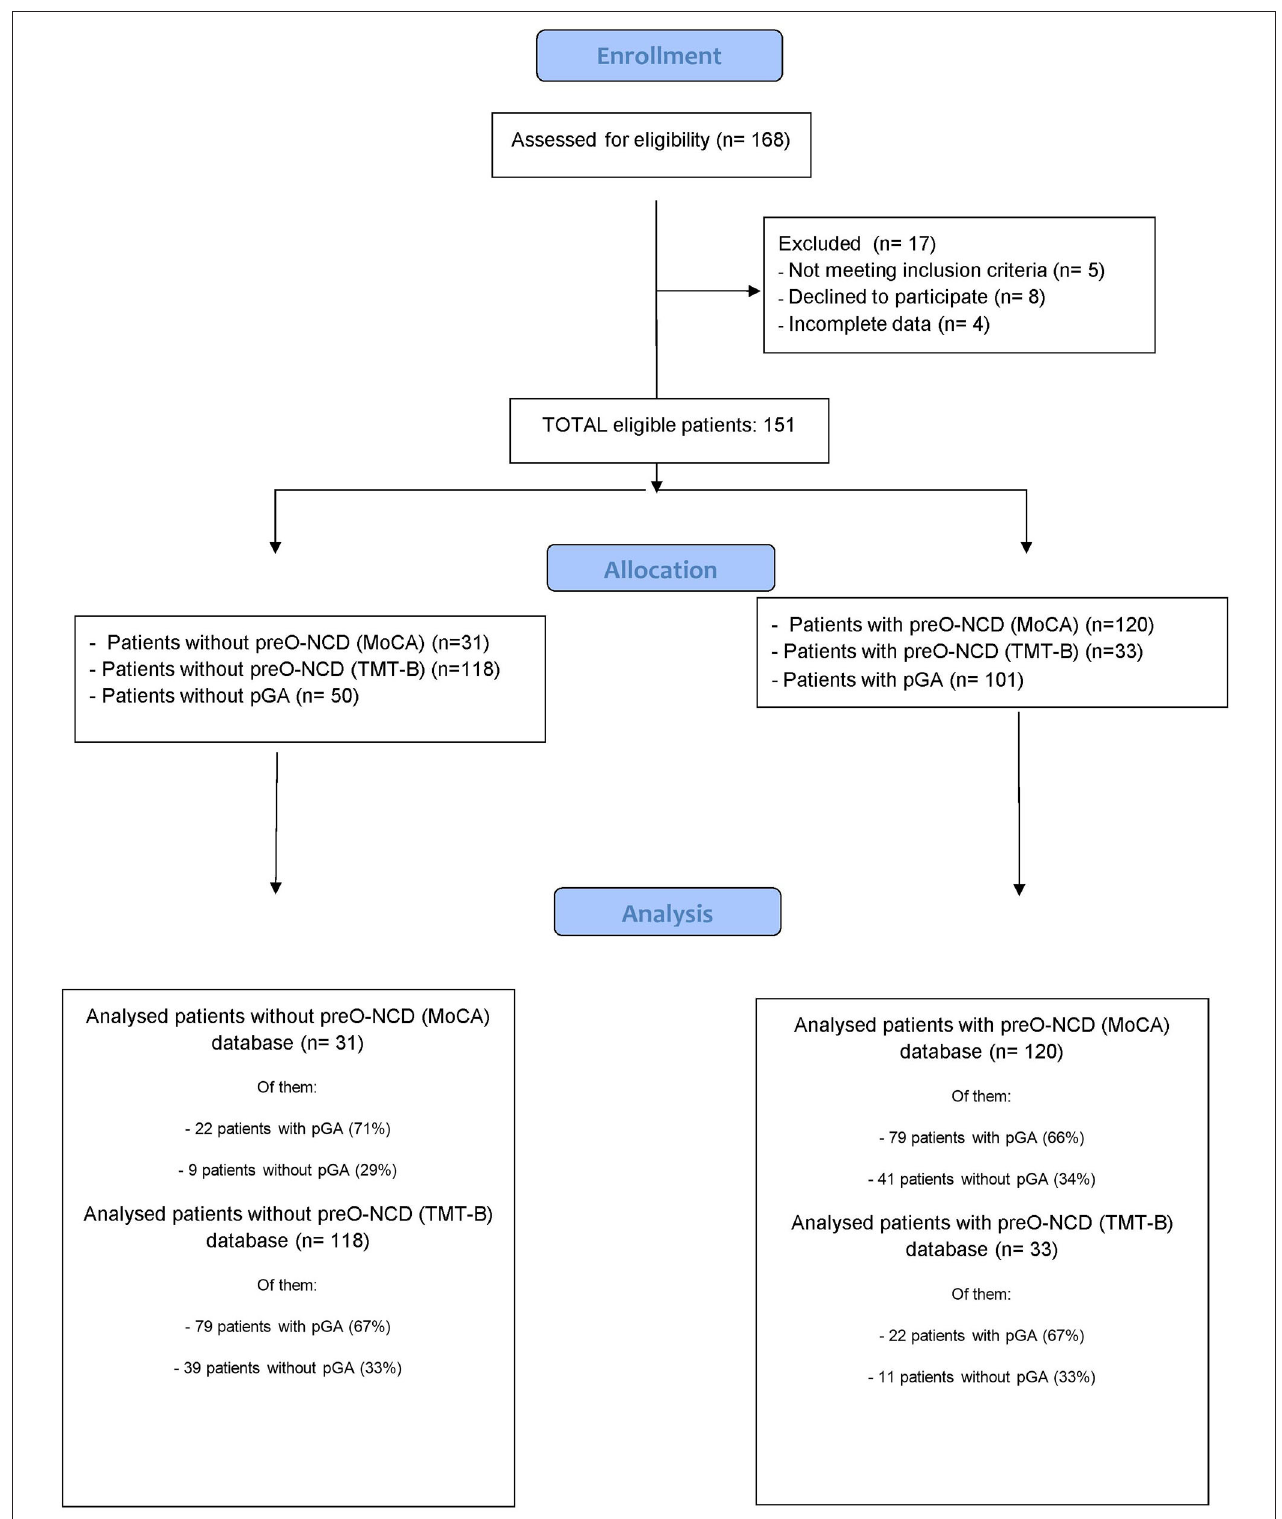
FIGURE 1 | Flow chart illustrating patients’ recruitment.